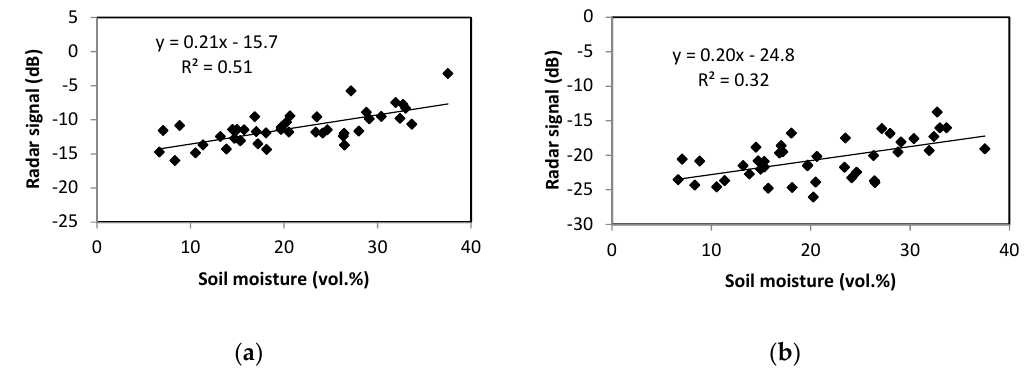
Figure 5. Phased Array Synthetic Aperture Radar (PALSAR) radar data as a function of soil moisture for bare soils: ( a ) horizontal-horizontal (HH) polarization, ( b ) horizontal-vertical (HV)